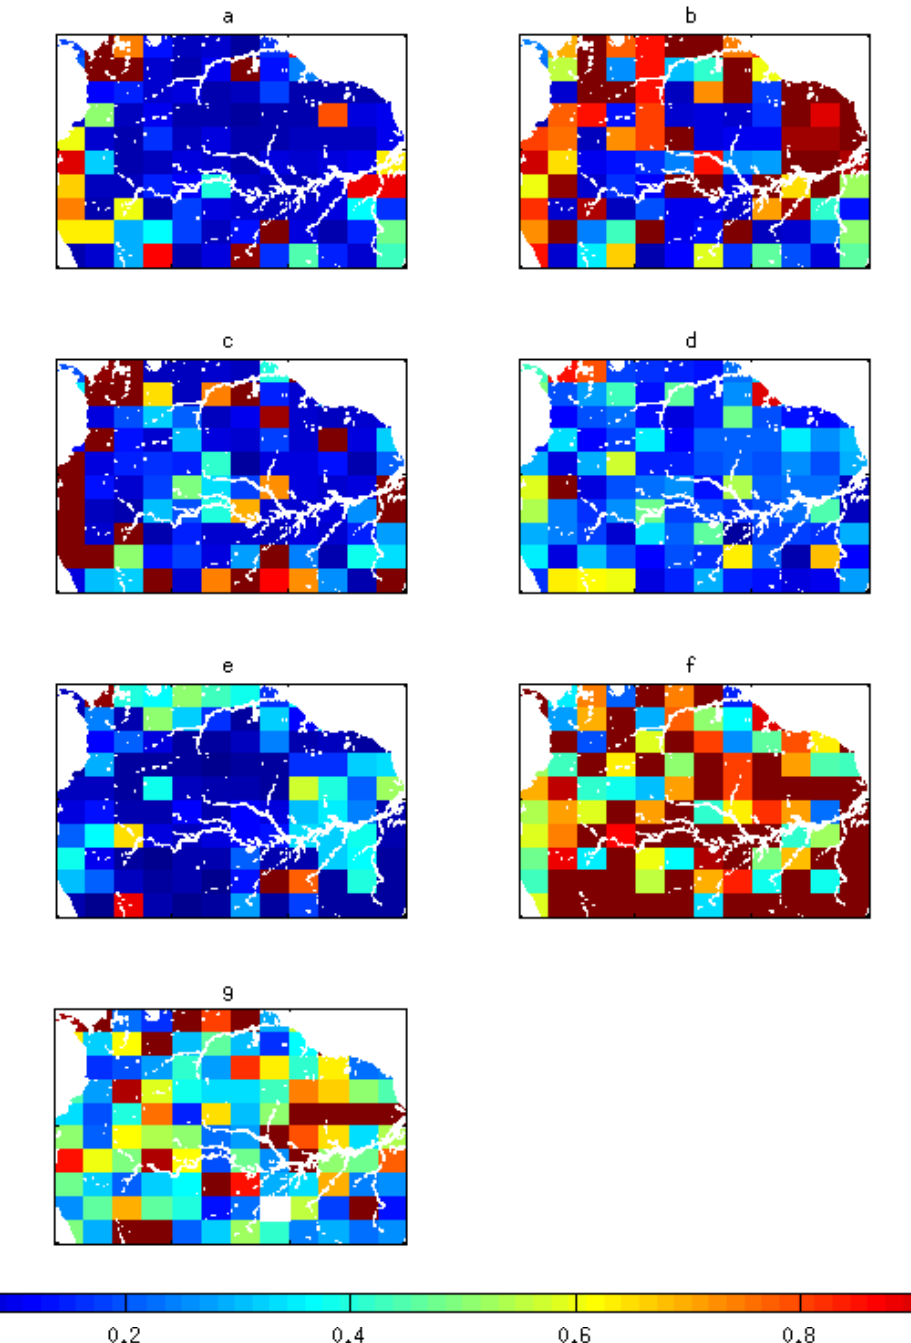
Fig. 7. Parameter uncertainty derived from the posterior distribution, expressed as 95% confidence intervals relative to posterior means for (a) direct PAR compensation point, C direct ; (b) diffuse PAR compensation point, C diffuse ; (c) delay in vegetation response to changes in PAR, p ; (d) maximum number of leaves that can be added over a month, gain max ; (e) age after which age related decay starts, age crit ; (f) background decay constant, µ 0 and (g) age-related decay constant, µ 1